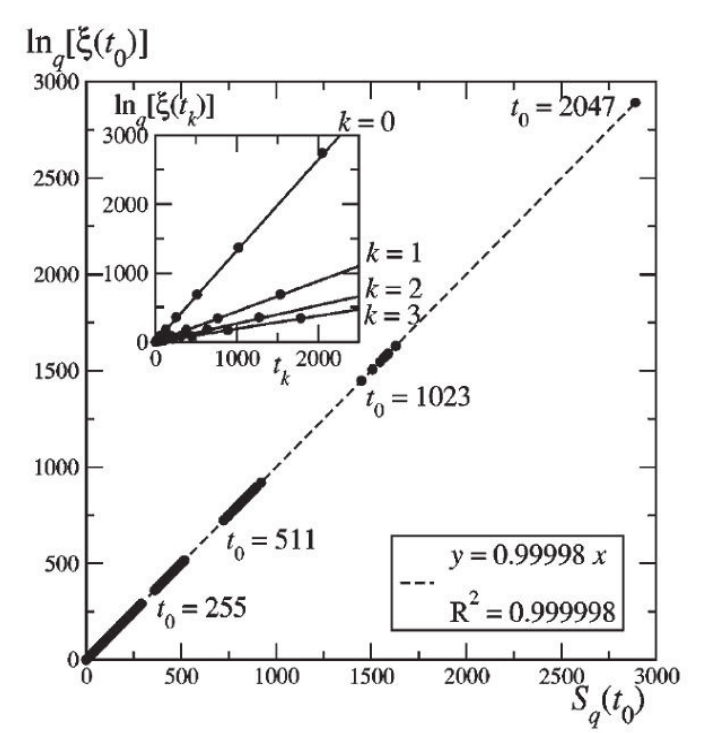
( k ) = λ ( k ) q q ( k ) (equal to λ q t ), k